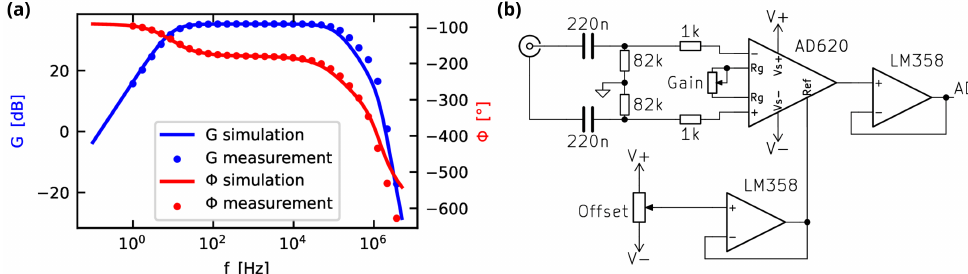
Figure A3. ( a ) Gain G and phase Φ of the analog processing circuit. Over a passband of 8 Hz to 120 kHz, the signal is inverted and amplified by 35 dB. ( b ) The transfer function is implemented by a first-order high-pass filter followed by an Analog Devices AD620 instrumentation amplifier. Gain and offset are variable by trim potentiometers. The buffered output is fed into the ADC of the ESP32. Power is supplied by two 9V